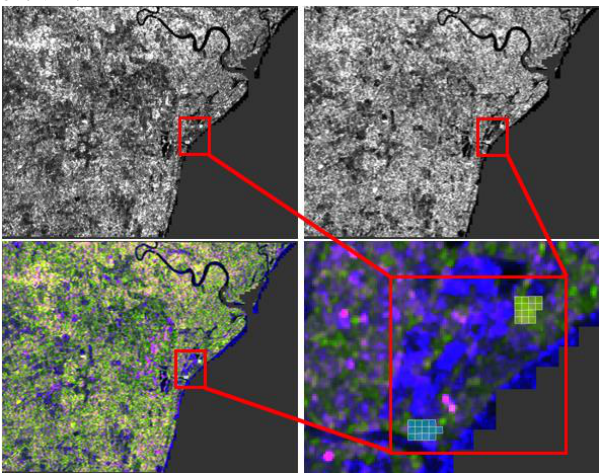
Two corresponding Sentinel-1A products with a sensing period of March 24, 2015 and November 12, 2015 for dense mangrove forest and sparse mangrove forest, respectively, were used in this study. The product is a level 1 GRD type which has been detected, multi-looked, and projected to ground range using WGS84 ellipsoid model. The sensor is in interferometric wide swath mode with swath width of (250 km) with a geometric resolution of (5 m by 20 m). The polarisations available are VV and VH.